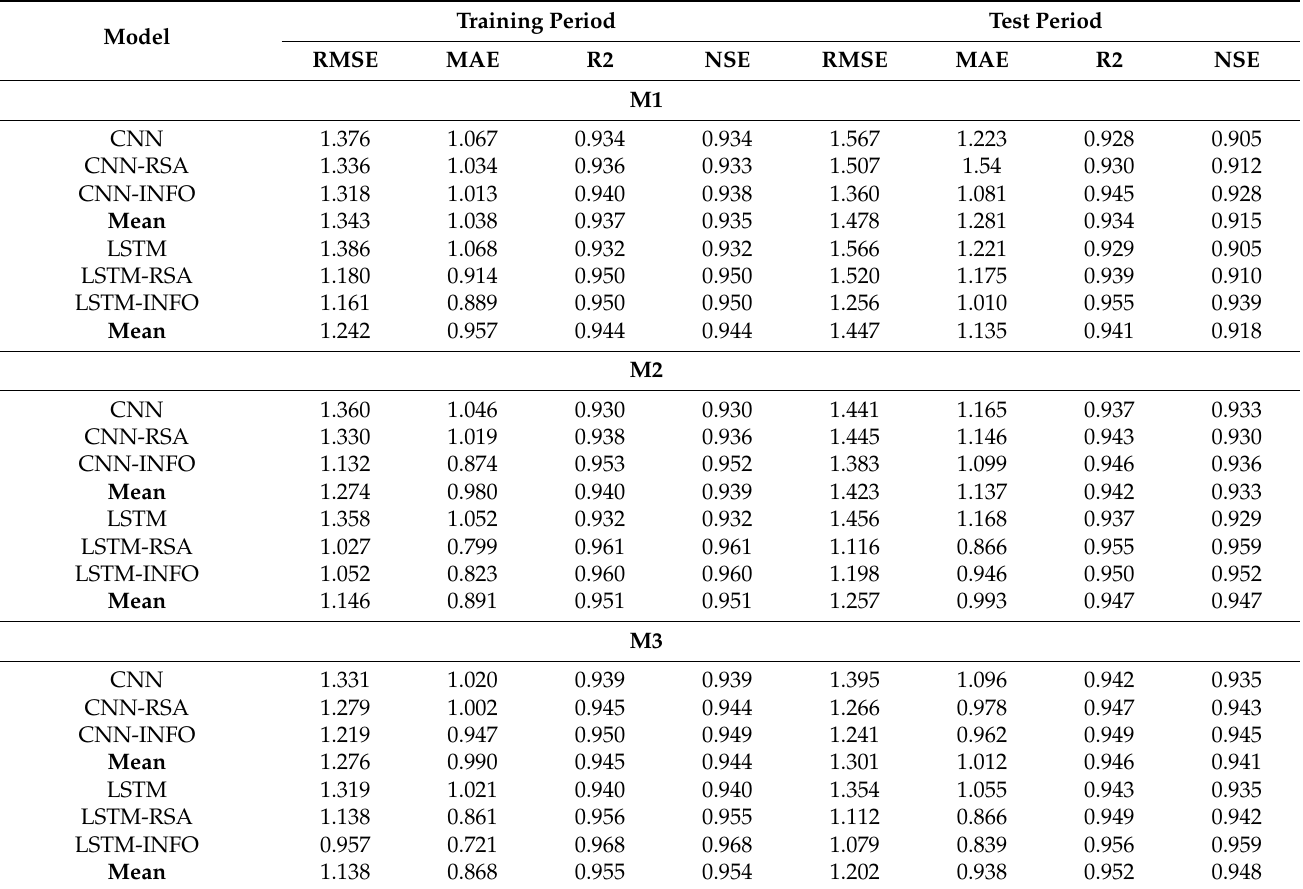
Table 10. Training and test statistics of the best input combinations of all applied models for water temperature